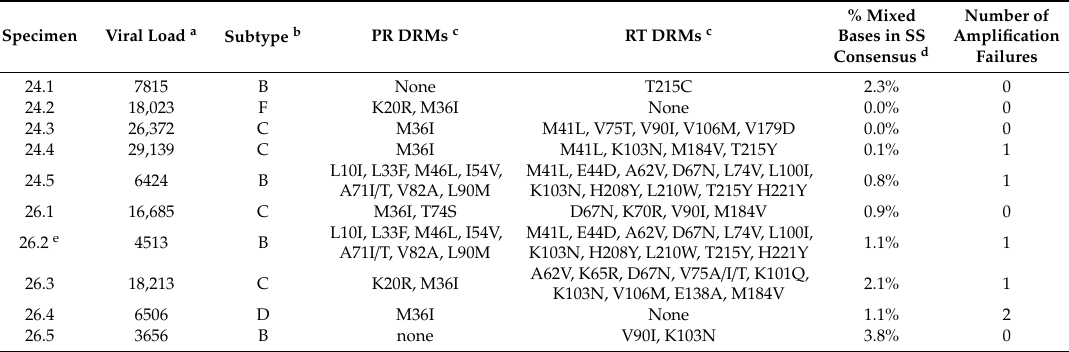
Table 1. Characteristics of Virology Quality Assurance (VQA) specimens used in this study.